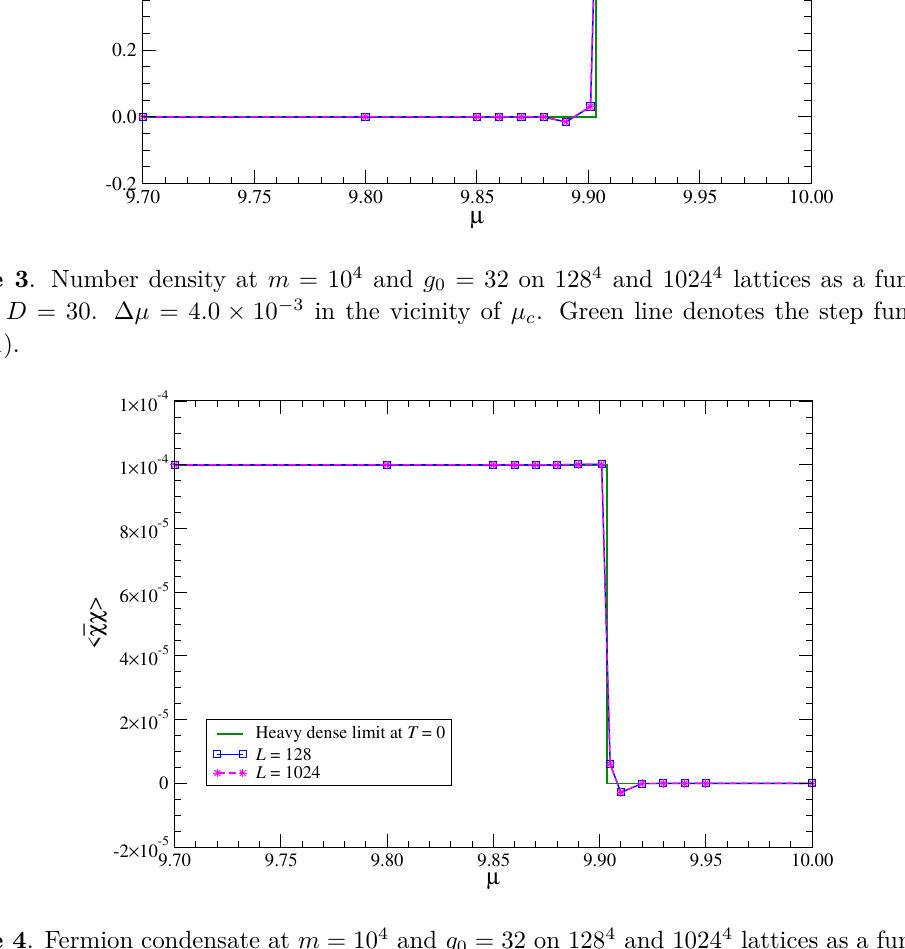
Figure 4 . Fermion condensate at m = 10 4 and g 0 = 32 on 128 4 and 1024 4 lattices as a function of µ with D = 30 . Green line denotes the step function in eq.